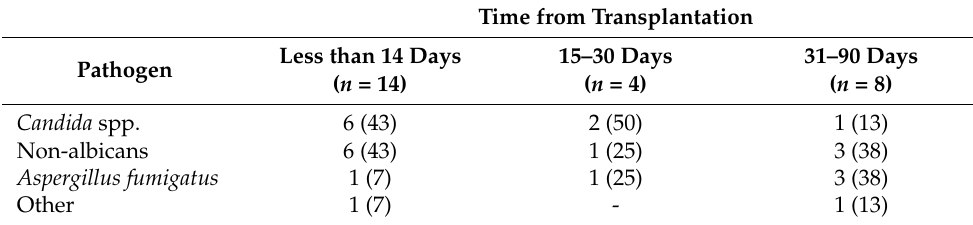
Table 8. Time to diagnosis for invasive fungal infections.